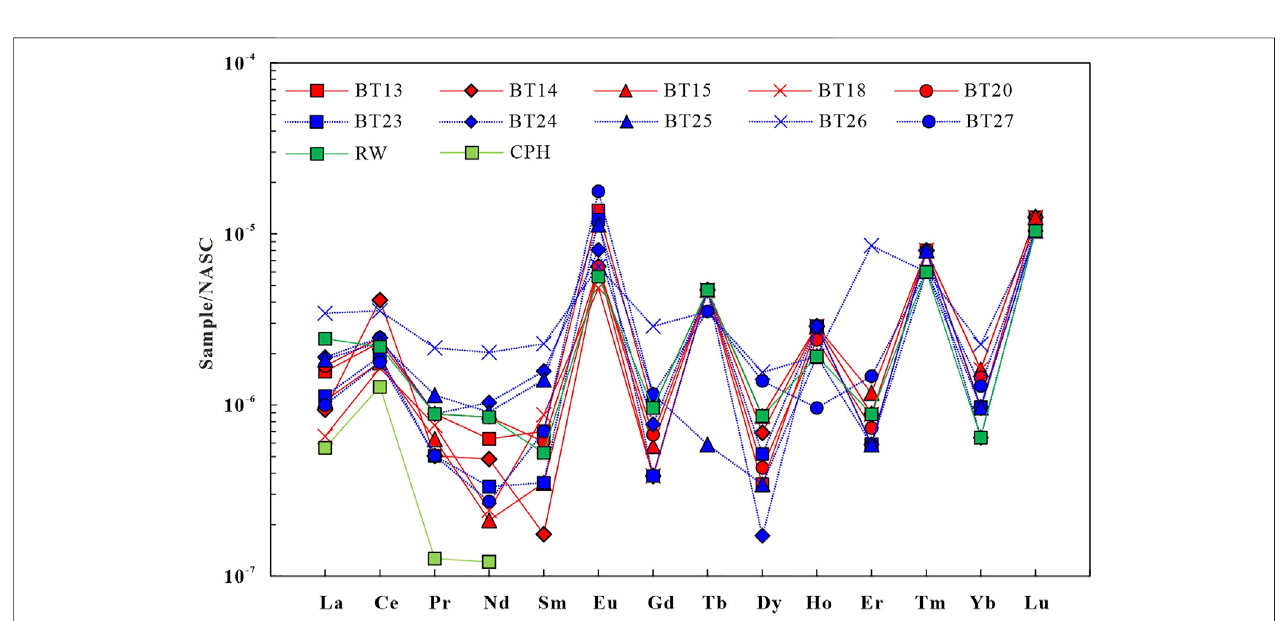
FIGURE 8 | North American shale standardized partitioning pattern of geothermal water and surface water rare Earth elements in the study area.